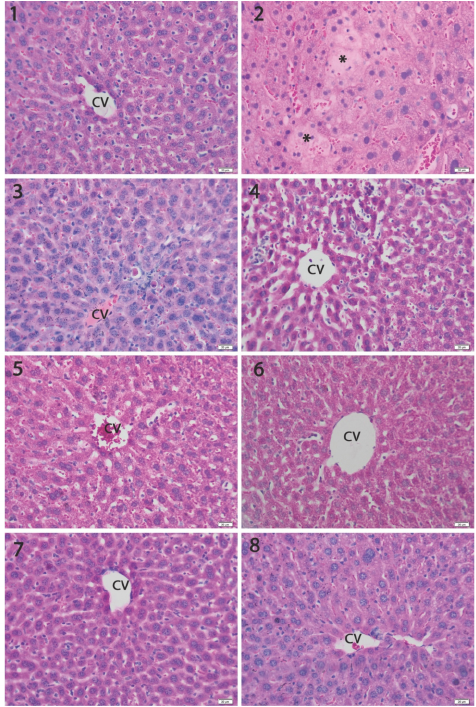
Figure 5. The histopathological sections of mice livers of the experimental groups, H&E barr 20 µ m. Various degrees of histopathological changes were observed in Cd exposure groups, mainly including focal hepatocyte necrosis/lysis (*) and degeneration. The co-administration of SeNPs with Cd reduced the metal toxic histological changes in the liver in a dose-dependent manner, which was more obvious for LSeNPs. CV-centrilobular vein. Groups: 1—control; 2—CdCl 2 ; 3—CdCl 2 + 0.1 mg/kg SeNPs; 4—CdCl 2 + 0.2 mg/kg SeNPs; 5—CdCl 2 + 0.4 mg/kg SeNPs; 6—CdCl 2 + 0.1 mg/kg